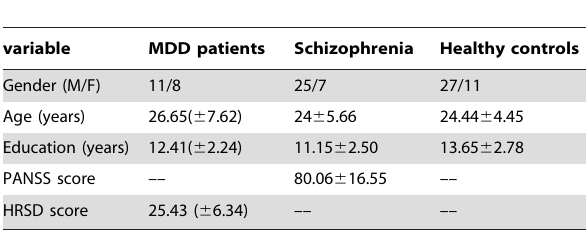
Table 1. Demographic and clinical profiles of the participants in this